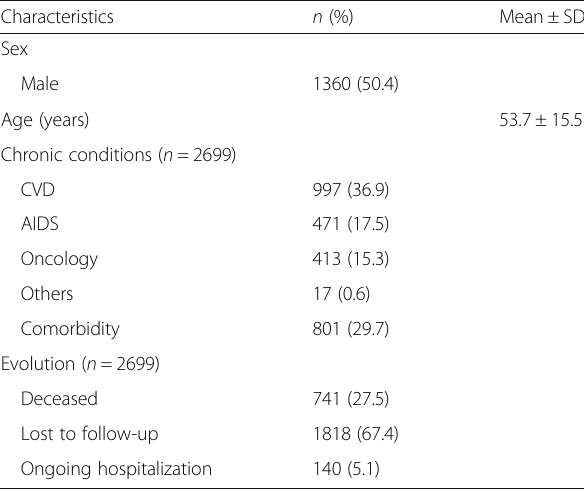
Table 1 Sociodemographic characteristics, health problems and outcomes of